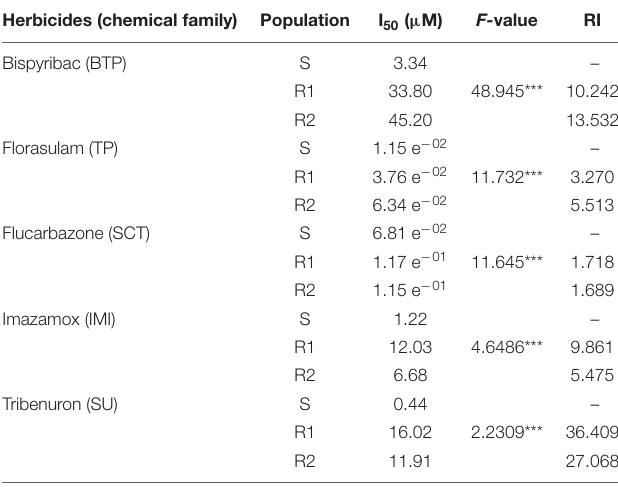
TABLE 3 | The resistance levels of different G. coronaria populations to bispyribac, florasulam, flucarbazone, imazamox, and tribenuron herbicides. Herbicides (chemical family)